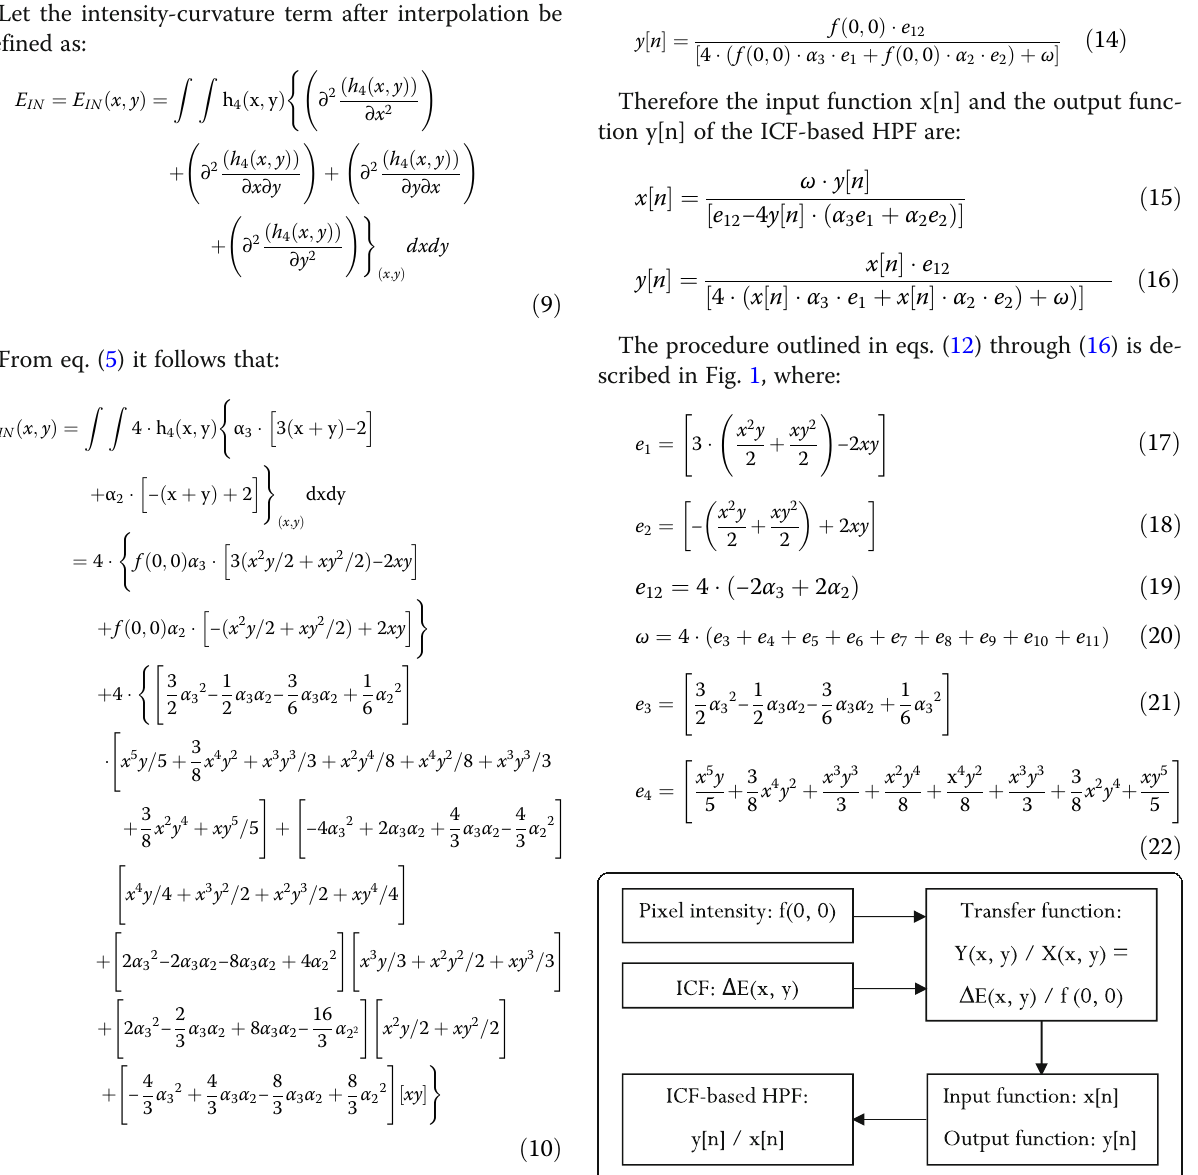
Fig. 1 Flowchart for the calculation of ICF-based